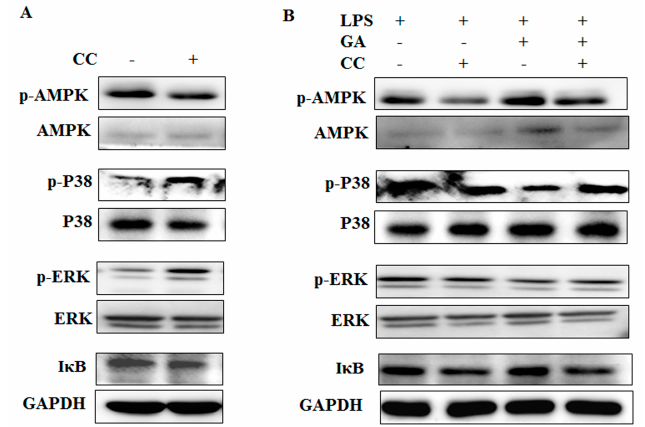
Figure 6. GA inhibits NF- κ B and MAPK pathways through AMPK activation in LPS-stimulated mouse peritoneal macrophages. Mouse peritoneal macrophages were pre-treated with 12.5 μ M CC for 1 h, followed by GA (20 μ g/mL) treatment for 1 h, and LPS (500 ng/mL) stimulation for 0 min ( A ) or 30 min ( B ) subsequently. Total cellular proteins were obtained and subjected to Western blotting to detect the phosphorylation of AMPK, ERK, and p38 and the degradation of I κ B. CC, compound C.